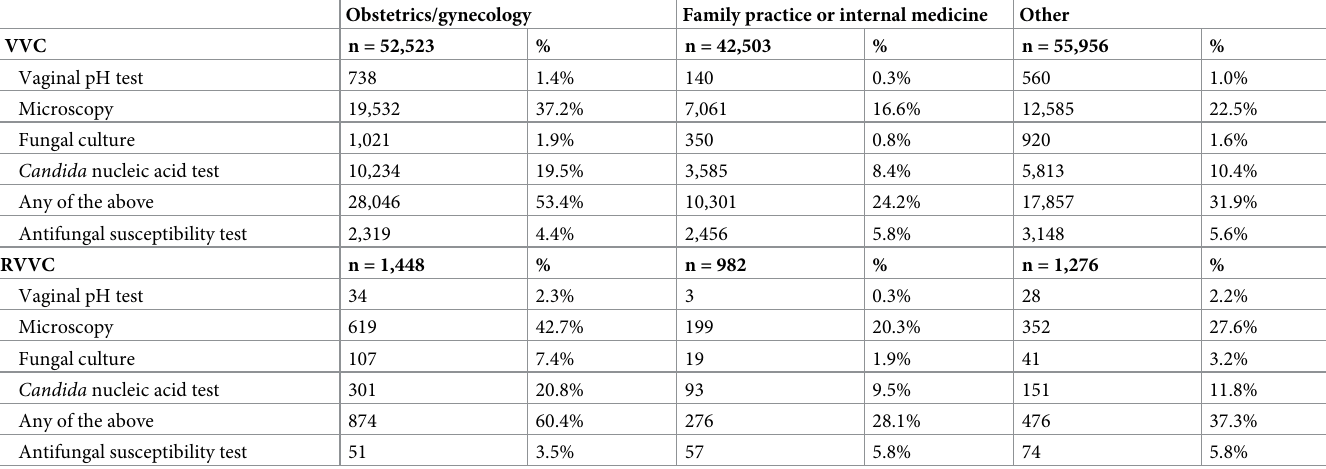
Table 3. Diagnostic testing by healthcare provider type visited on the index date, among patients with vulvovaginal